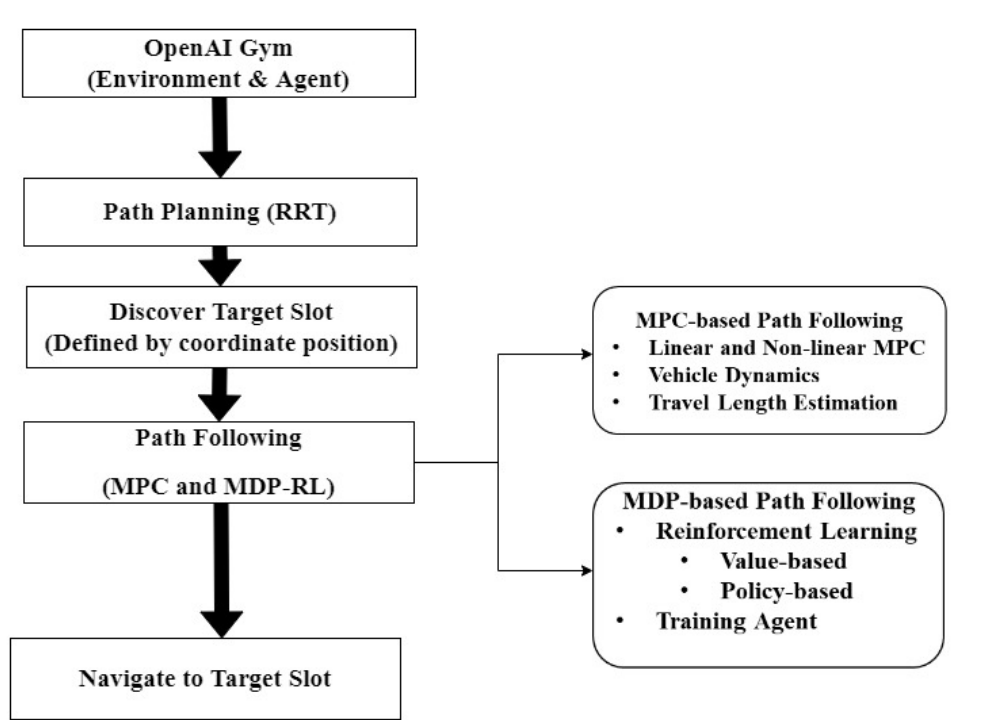
Figure 3. Flowchart of the proposed method, describing the workflow for path planning, path following, and travel length estimation.